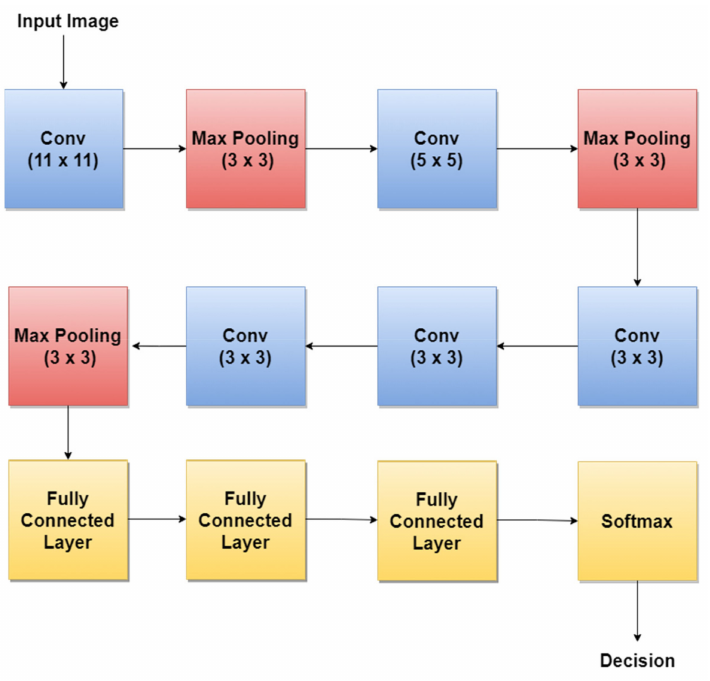
Figure 9. AlexNet basic